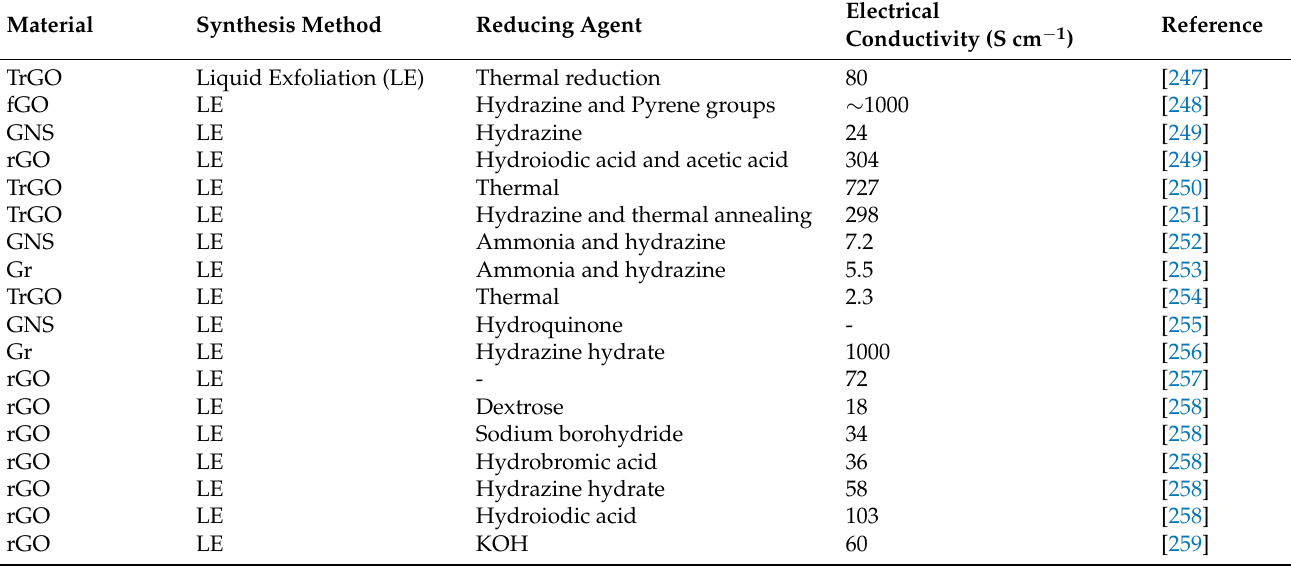
Table 2. A study of the literature on the electrical conductivity of several graphene